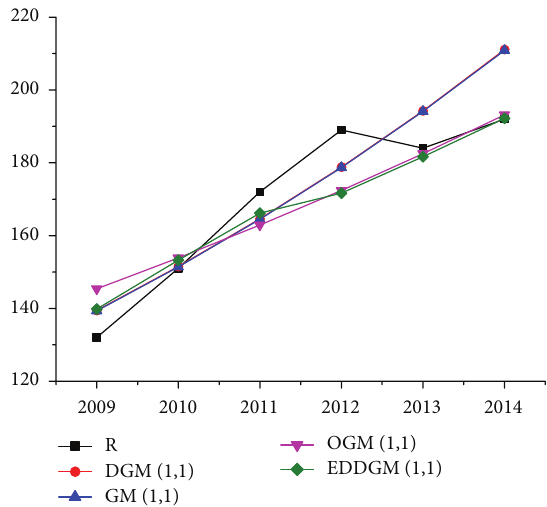
Figure 4: Comparison between the fitting and actual values using four models.